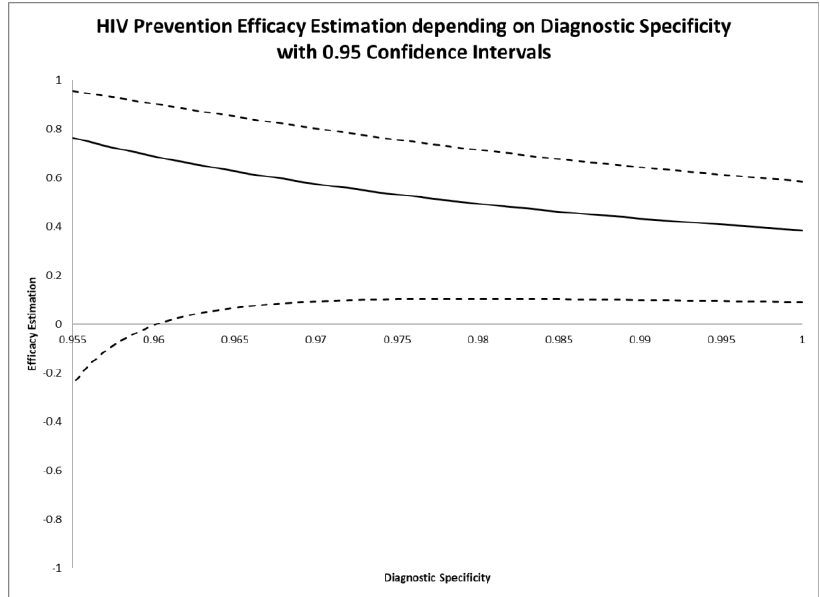
Figure 1. Adjusted efficacy estimates ( y -axis) depending on endpoint specificity ( x -axis) applying equation (7) with 0.95 confidence intervals and using equation (9) for the primary endpoint of the CAPRISA 004 trial.